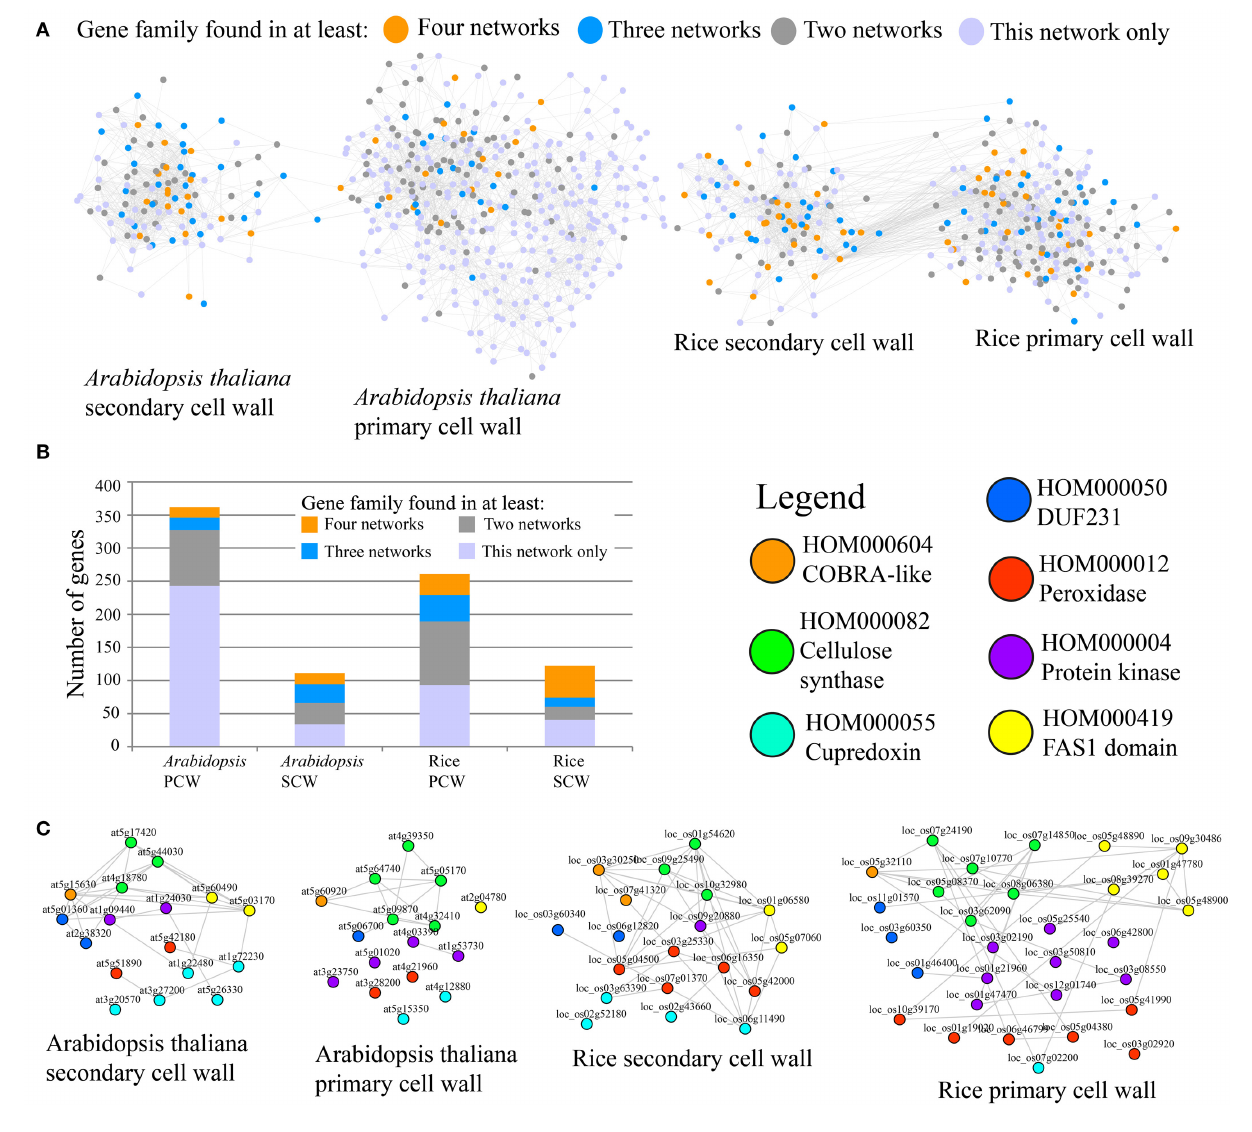
FIGURE 1 | Comparative co-expression networks of cellulose biosynthesis. (A) Co-expression networks of Arabidopsis and rice primary secondary cell walls. Nodes and edges represent genes and co-expression relationships between genes, respectively. Node colors indicate degree of conservation of families present in the four networks (legend). (B) Distribution of conservation classes in the four